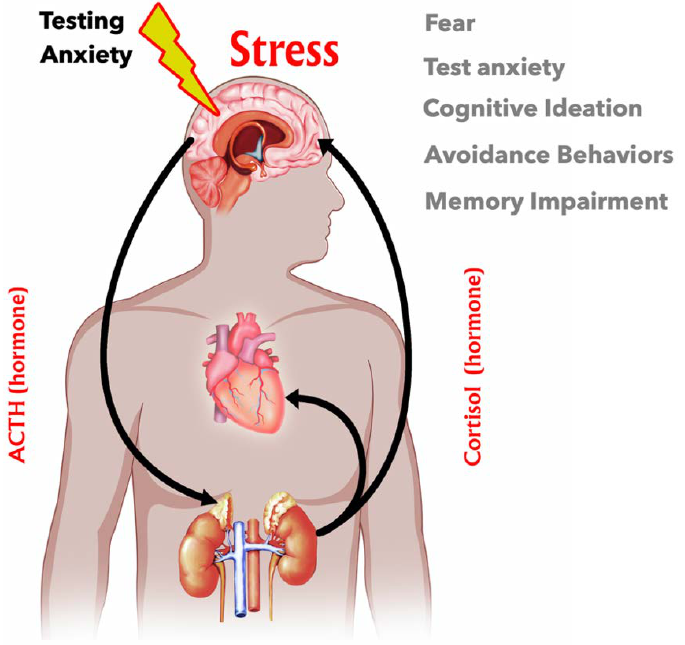
Figure 1. Stress Response in the Human Body. In response to stress, cerebral cortex signaling stimulates the hypothalamus to release corticotropin-releasing hormone (CRH). In turn, CRH stimulates the pituitary gland to produce and release adrenocorticotropic hormone (ACTH) into the blood. ACTH then activates pathways in the adrenal glands for the synthesis and release of the stress hormone cortisol. As a consequence of chronic stress, such as repeated test anxiety, over-stimulation by cortisol can lead to the indicated deleterious side effects in the brain and central nervous system. The adrenal glands are small, but they play a significant role in the body. Hormones released from the adrenal glands can be in minute levels in the blood but serve as signifi-